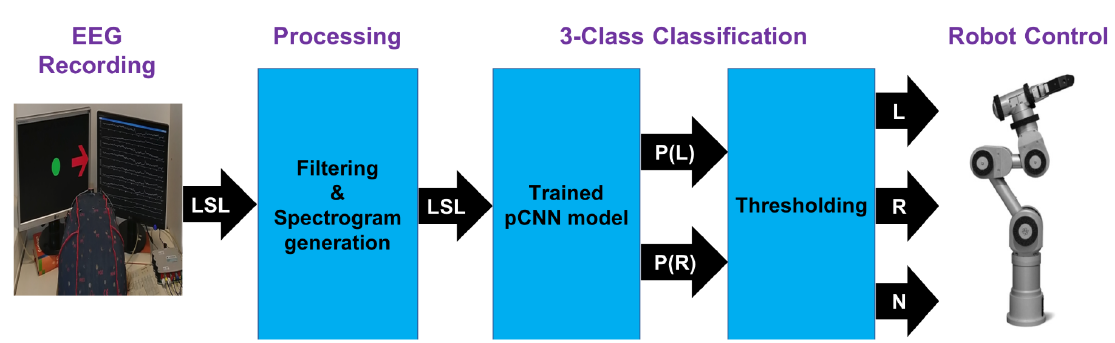
Figure 8. Live setup for real-time EEG signal decoding and Katana robot arm control. P(L) and P(R) represent the probability of left and right hand movements,